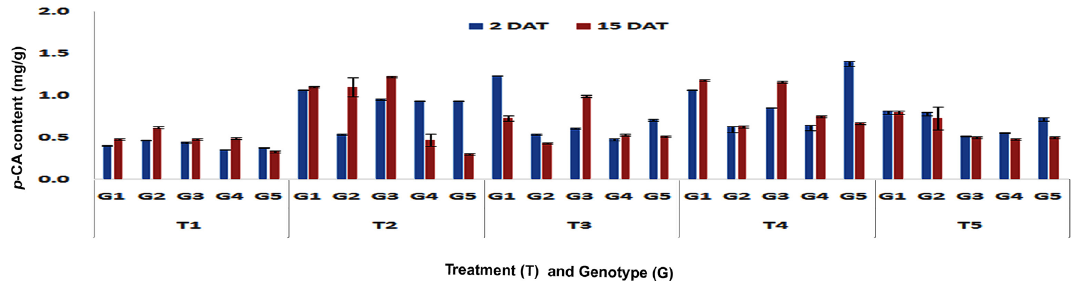
Figure 3. Changes in p -CA content in stalk tissues of maize genotypes to induced treatments in short (2 DAT) and long (15 DAT) term responses on the imposition of treatments at V3 stage (G1: DMRE 63; G2: CM 500;